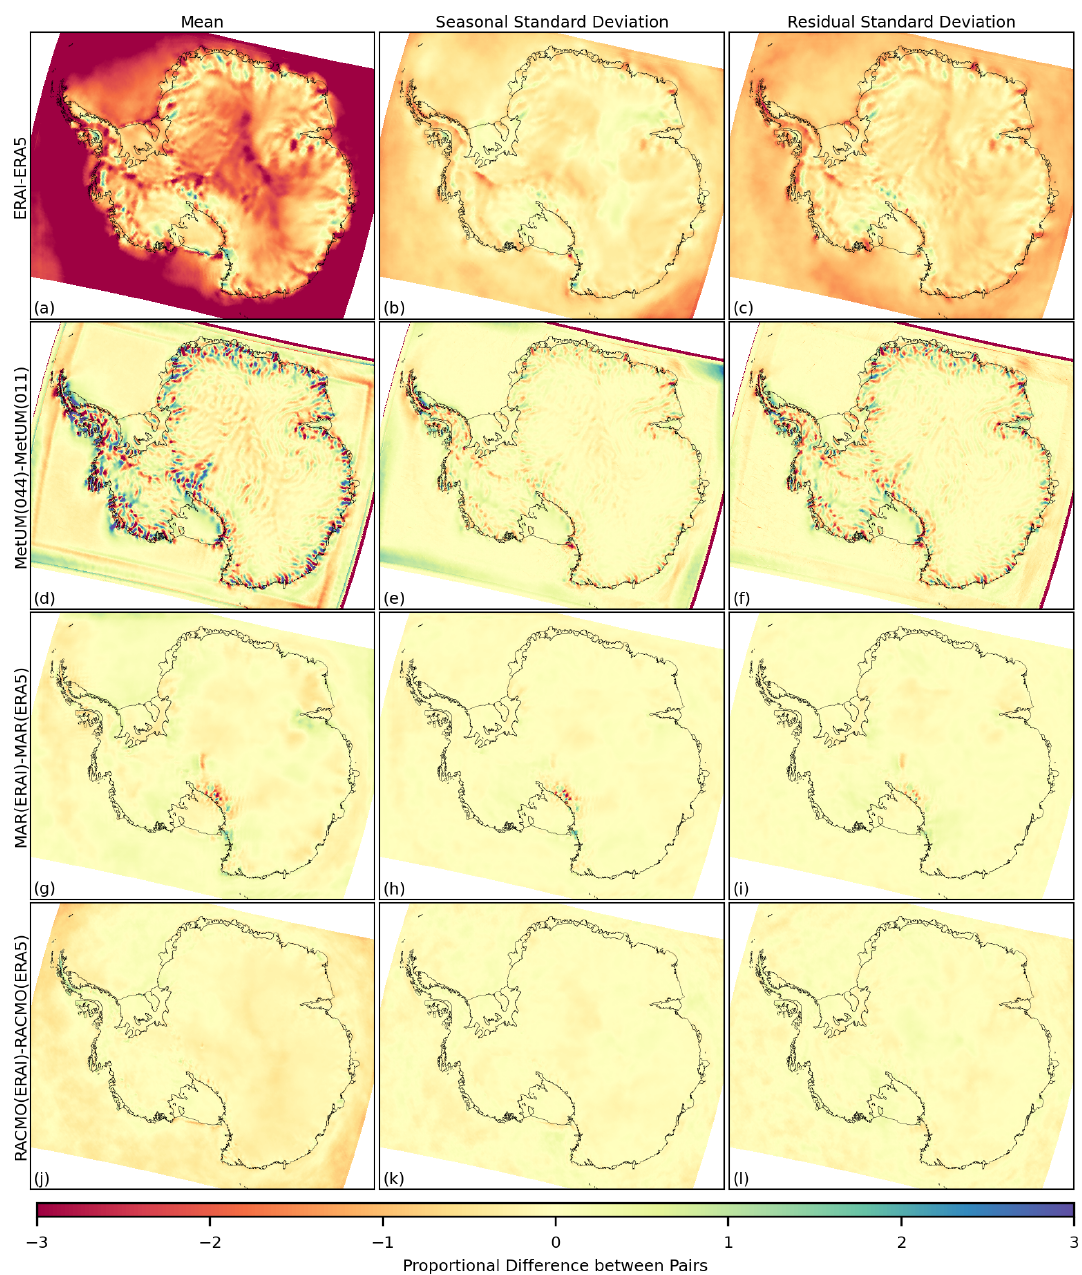
Figure B1. The difference for the 1981–2018 time series of snowfall, in the mean (a, d, g, j) , the standard deviation of the seasonal component (b, e, h, k) and the standard deviation of the residual component (c, f, i, l) between the following pairs of outputs: ERA-Interim relative to ERA5 (a–c) , MetUM(044) relative to MetUM(011) (d–f) , MAR(ERAI) relative to MAR(ERA5) (g–i) and RACMO(ERAI) relative to RACMO(ERA5) (j–l) . Differences at each grid cell are expressed as a proportion of average inter-annual variation and so do not have